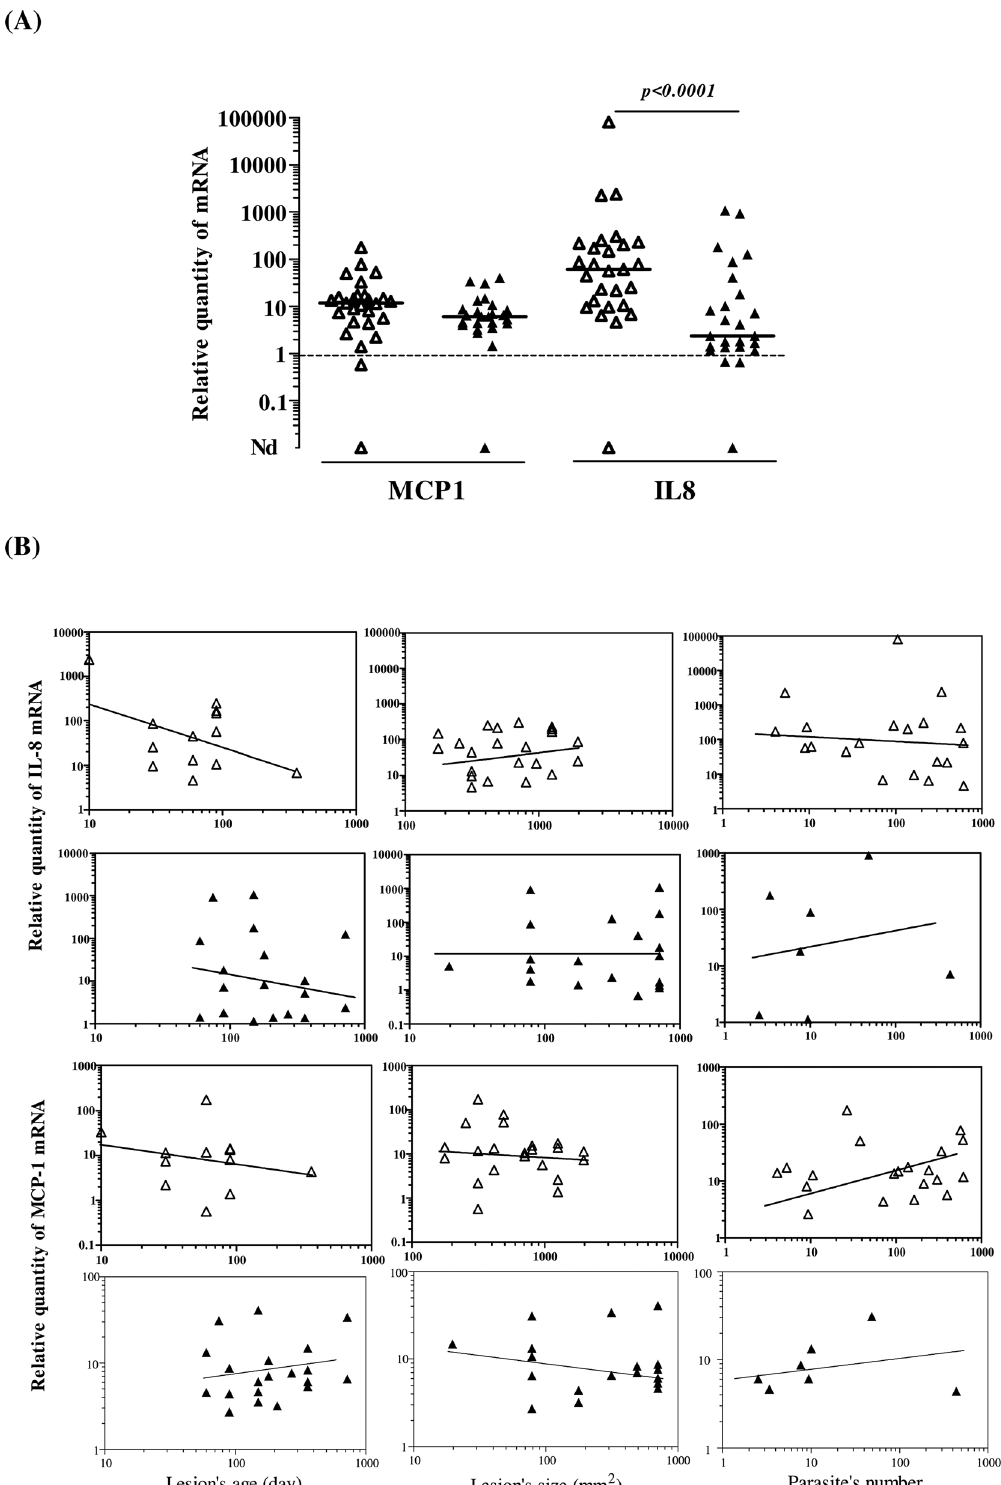
Figure 4. IL-8 and MCP-1 mRNA expression within ZCL and SCL lesions. (A) Dot-plots show individual values of IL-8 and MCP-1 mRNA expression within ZCL ( D ) and SCL ( N ) samples. Results are expressed as a ratio between levels of mRNA molecules in studied samples to those detected in normal skin. A horizontal bar indicates the median value of each group. (B) Correlation between IL-8 or MCP-1 mRNA levels and the age of lesions, their size, and the number of parasites they contain. Correlations between different variables were evaluated with the Spearman ’ s rank correlation test, r: correlation coef fi cient; p < 0.05 was considered statistically signi fi